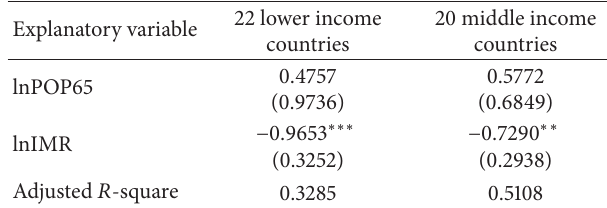
Table 3: Semiparametric regression results: country income